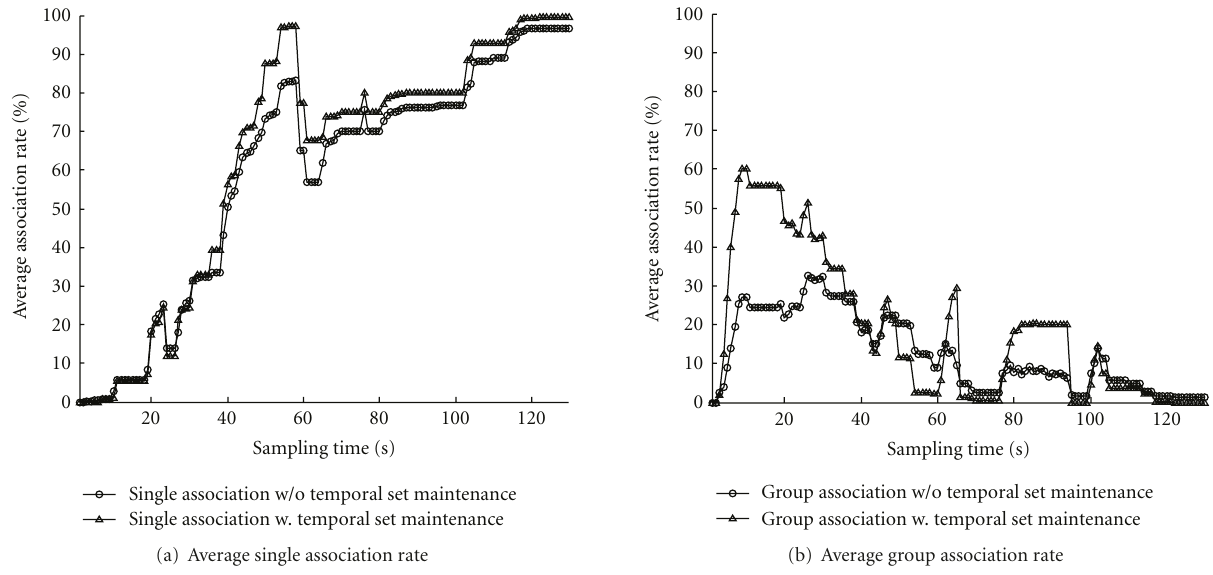
Figure 5: Comparison between the association performance with and without temporal set